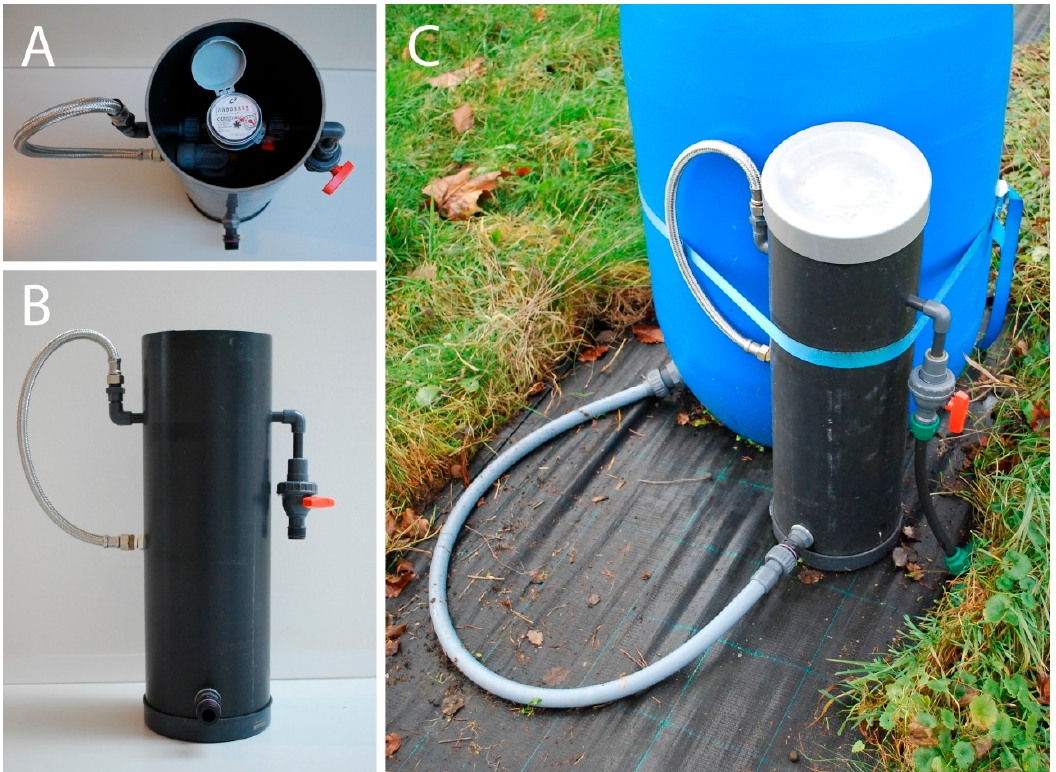
Figure 2. Water supply device. ( A ) View from above on the water meter (float valve positioned underneath). ( B ) View from the front. ( C ) Field installation.